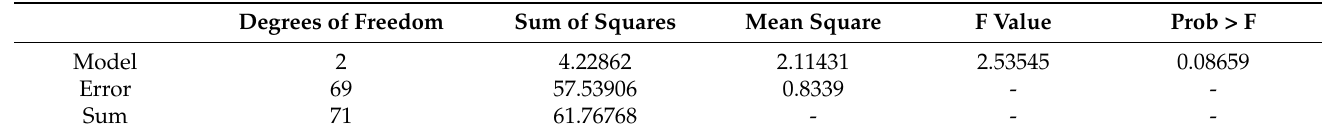
Table 5. Results of one-way analysis of variance between calculated and measured